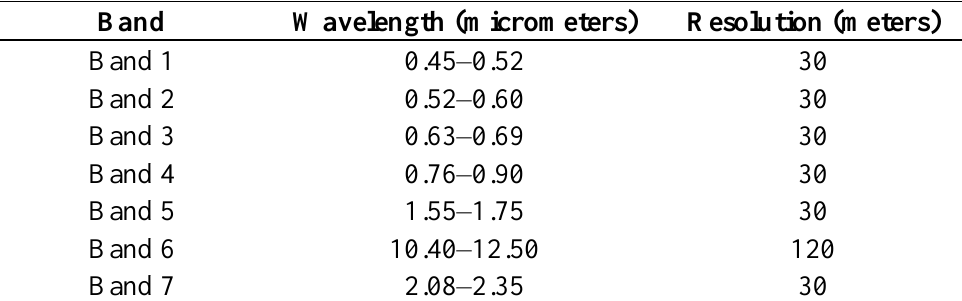
Table 2. Thematic Mapper (TM) band designations.